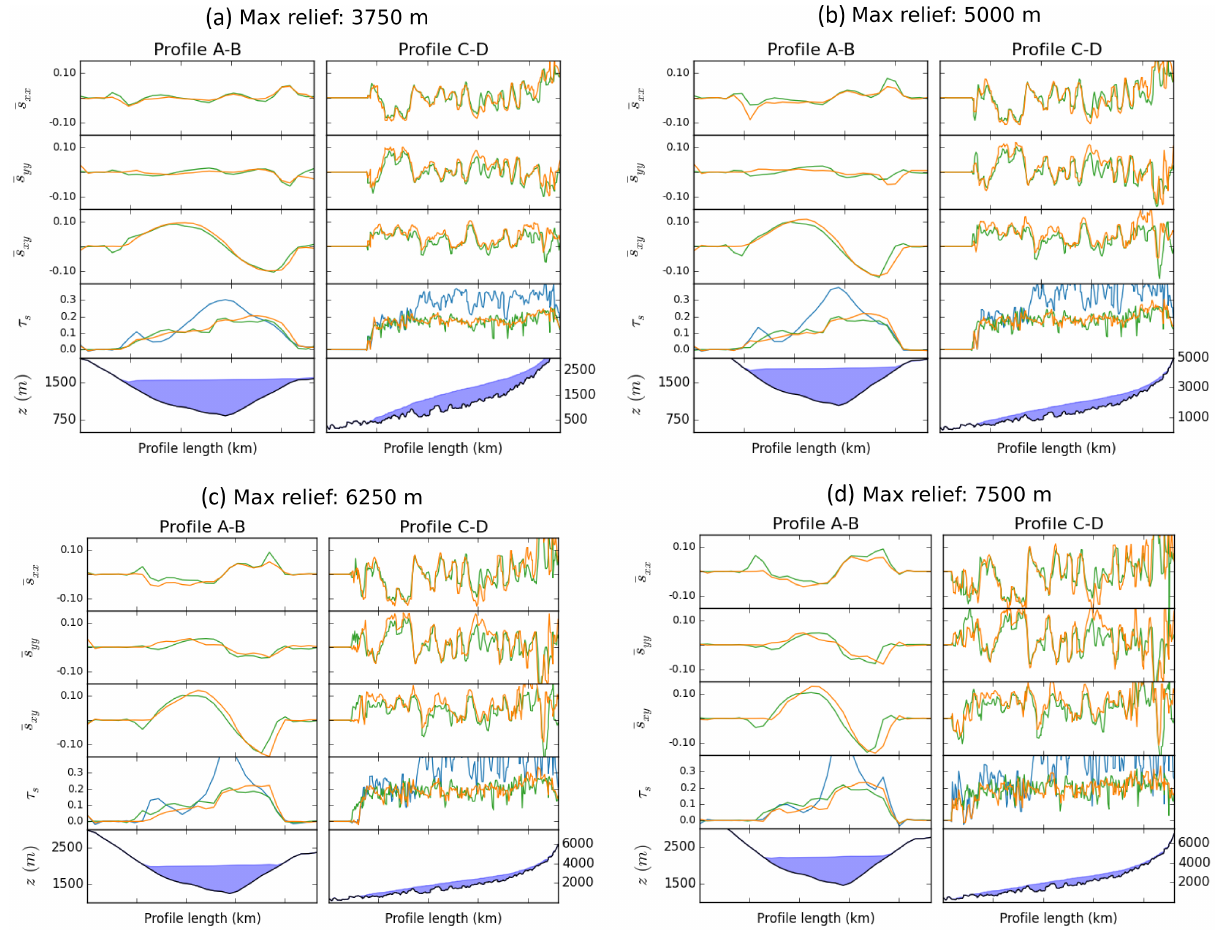
Figure 5. Stress components in MPa from iSOSIA (orange) and Elmer/Ice (green) for the increasing topographical relief in experiment 2. Left column of each panel (a–d) shows values along the transverse profile, A–B, while the right column is along the longitudinal profile, C–D (Fig. 3). The SIA driving stress approximation is also shown in the third row for comparison (blue line). Fourth row shows the ice-surface and bed topography along the same profiles. Note that elevation is indicated on both the left and right